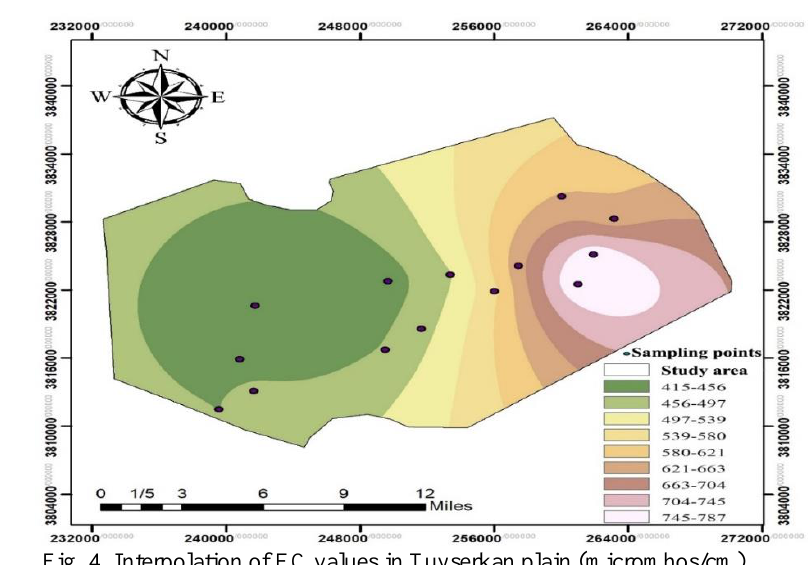
Fig. 4. Interpolation of EC values in Tuyserkan plain (micromhos/cm) Table 6. Results of MLP-ANN models with their structures Model 1 Number of input neurons 10 2 Teaching law Momentum Momentum Momentum Actuator function TanhAxon The number of hidden layers The number of processors intermediate